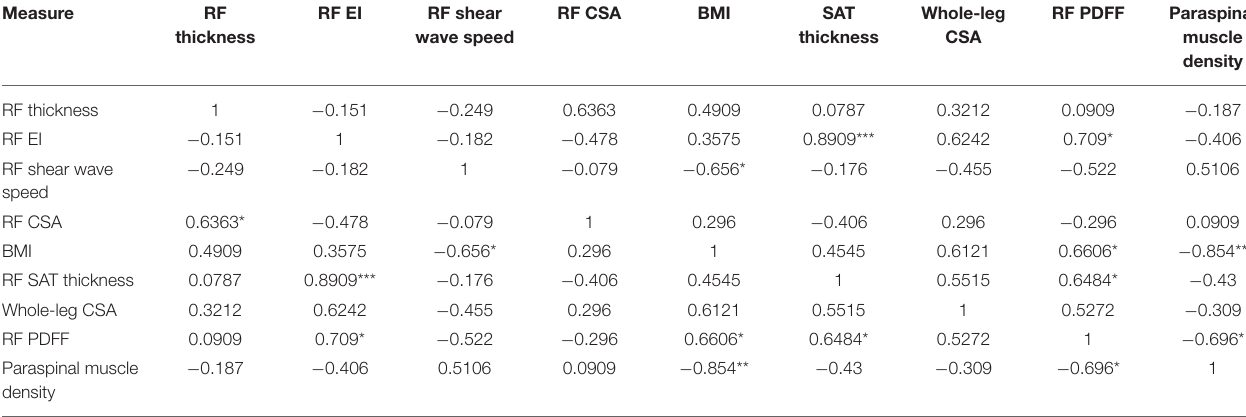
Whole-leg RF PDFF Paraspinal thickness CSA muscle density